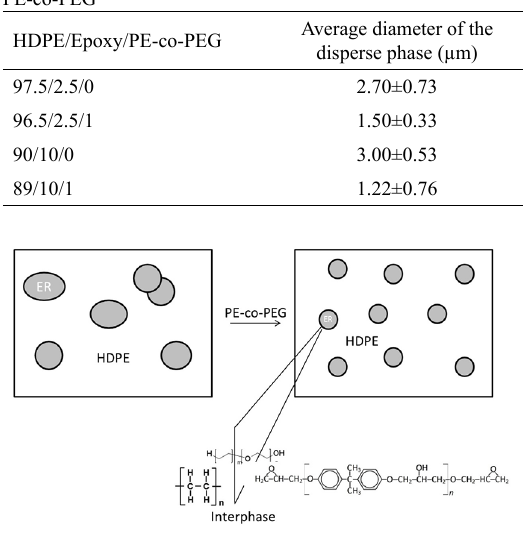
Figure 5. Schematic illustration of role of PE-co-PEG in HDPE/ epoxy blend. improved the homogeneity of epoxy phase distribution when compared with uncomptabilized blends (Figure 4 (a) and Figure